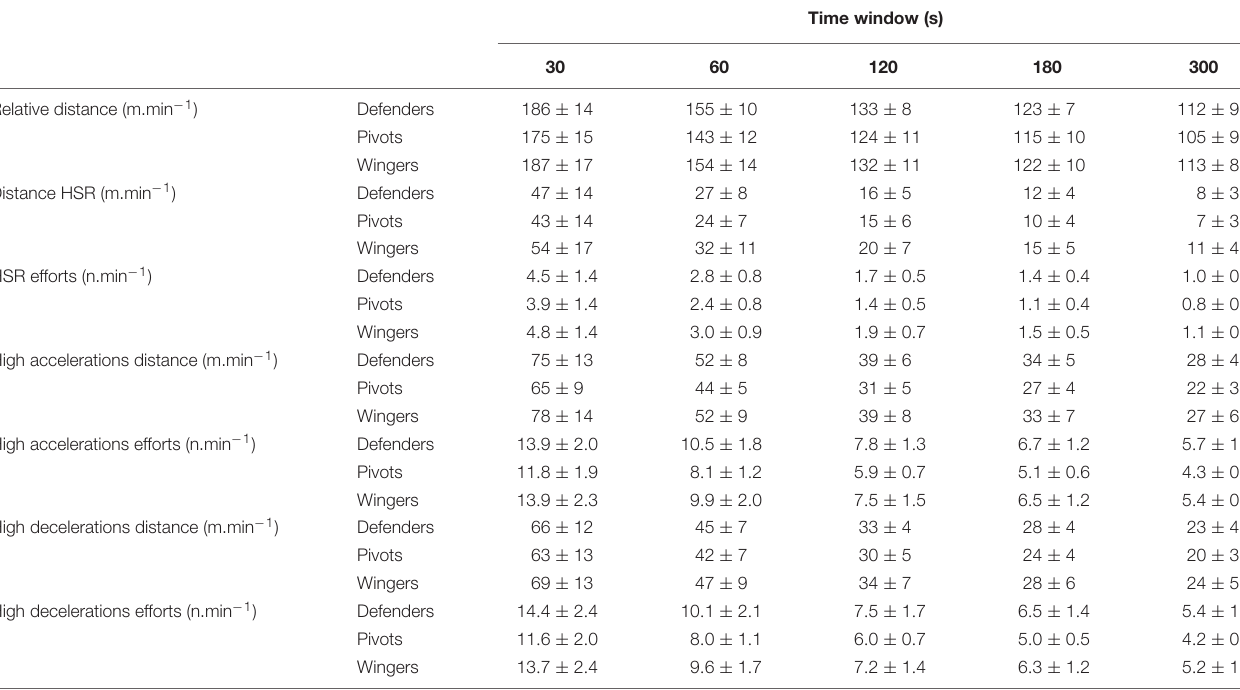
TABLE 1 | Descriptive statistics for the most demanding scenarios of each dependent variable assessed across five time windows.